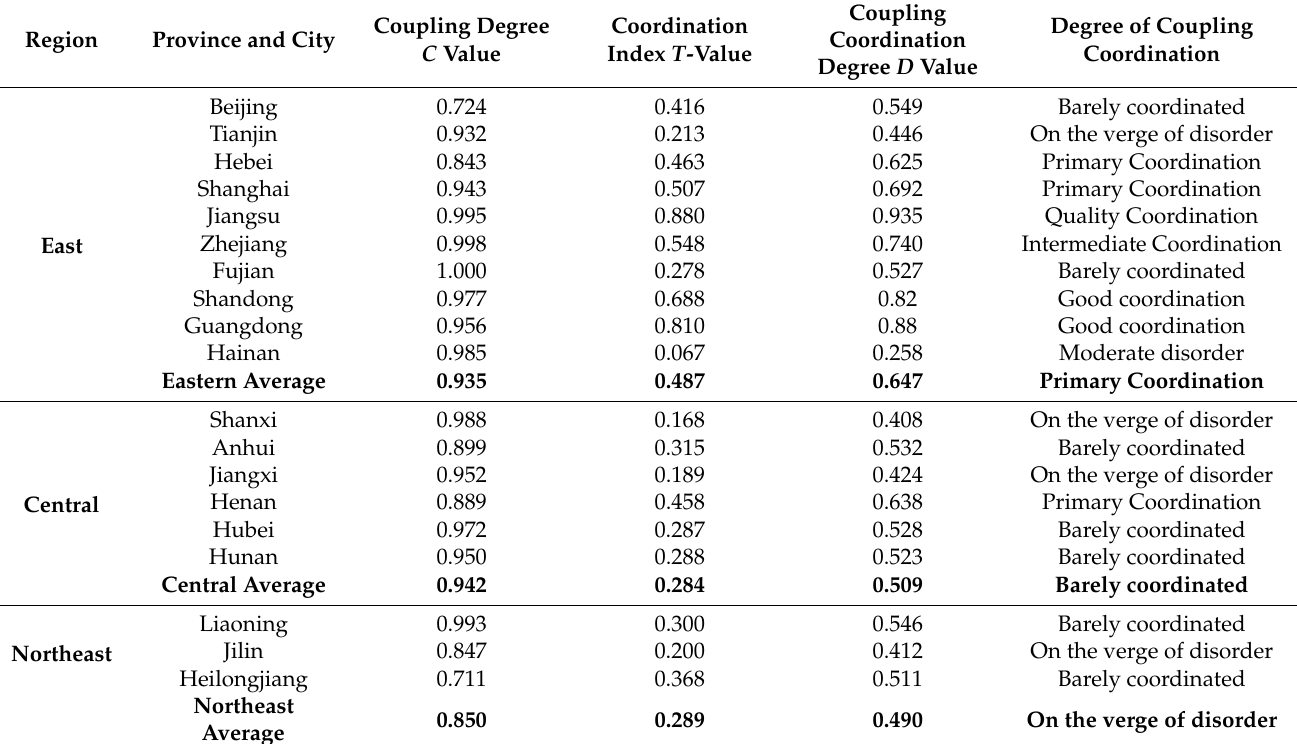
Table 5. 2011–2020 Average status of coupling and coordination between agricultural modernization and regional economic development system by provinces and cities in